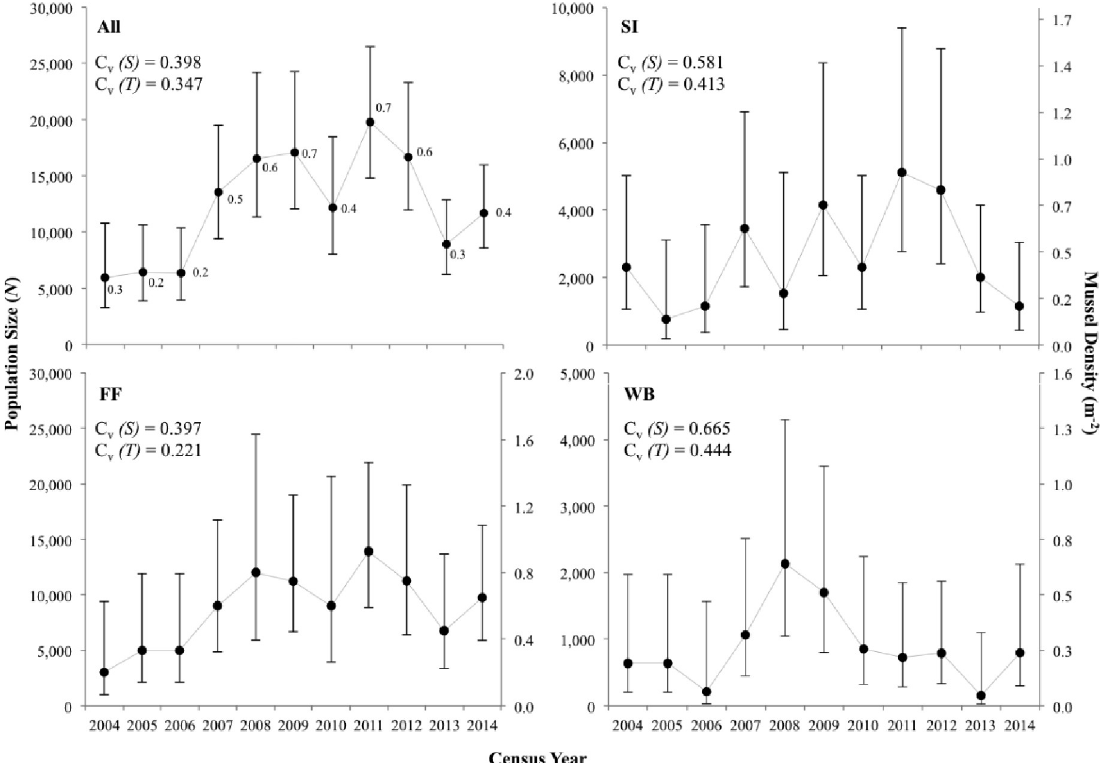
Fig 2. Estimates of population size and mean density (bars represent 95% confidence limits corrected for non-normality) for Epioblasma brevidens in the Clinch River, Hancock County, TN, at Frost Ford (FF), Swan Island (SI), Wallen Bend (WB), and population size averaged across all three sites (All) from 2004–2014. Numbers next to point estimates on All plot indicate average density across the 3 sites. The value C v ( S) is the total coefficient of variation measured in the time series, which includes both sampling error variance S 2 ( ^ N ) and true temporal process variance. The value C v (T) is true temporal process variation, after mean S 2 ( ^ N ) was removed from C ( S) v